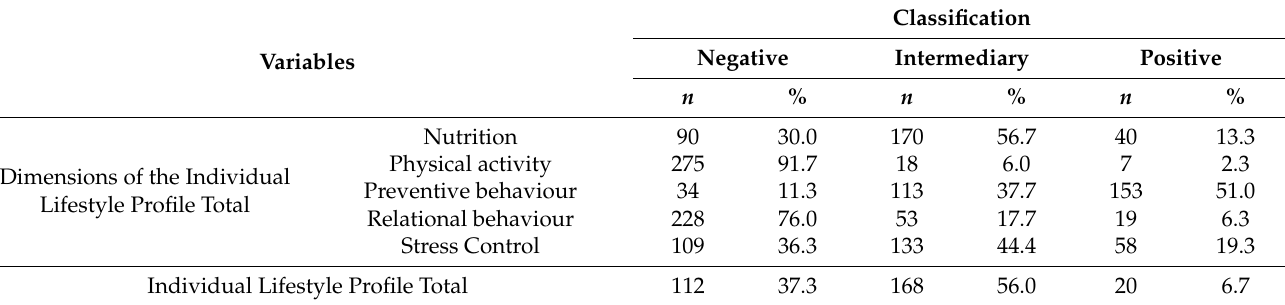
Table 3. Classification of the dimensions of the individual lifestyle profile and individual lifestyle (N =